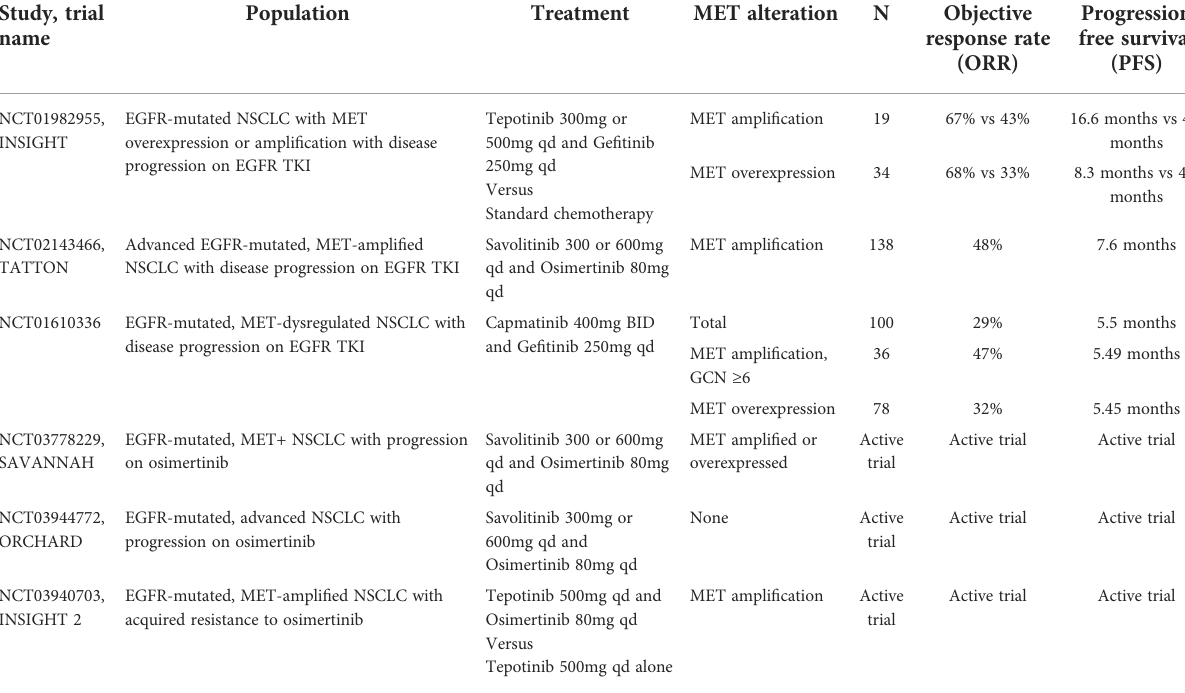
TABLE 3 Trials of MET TKIs in Acquired EGFR